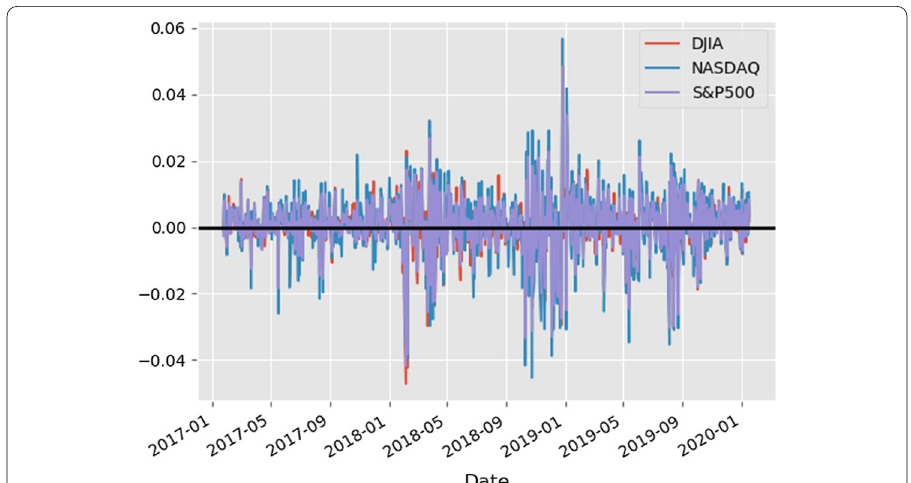
Fig. 7 Daily change in each stock of the three stock market indices, the Dow Jones Industrial Average (DJIA), NASDAQ and S&P 500, during the period between January 20, 2017 and January 20, 2020